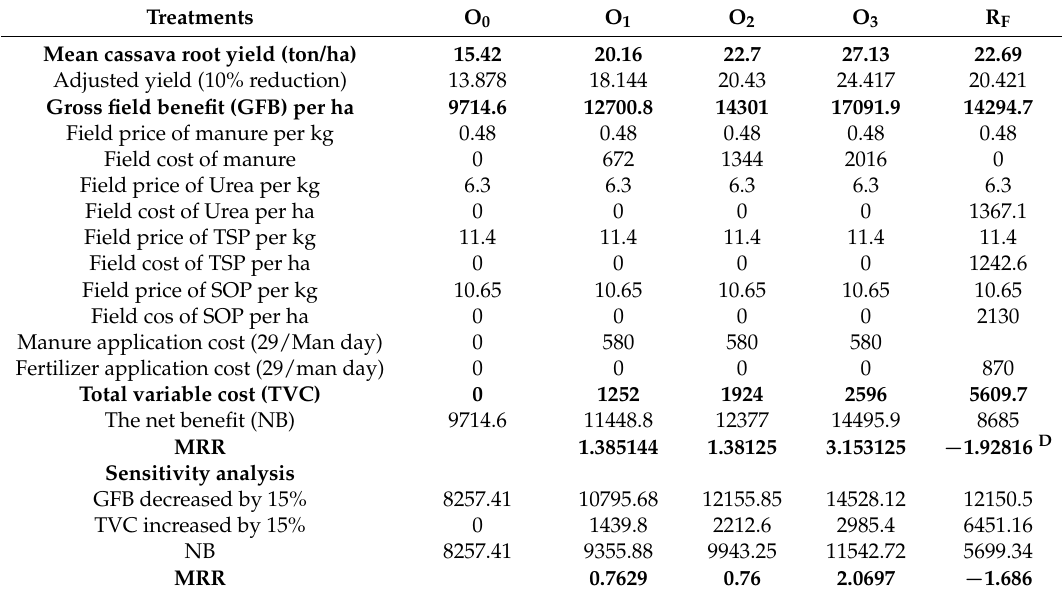
Table 7. Comparison of marginal rate of return between the